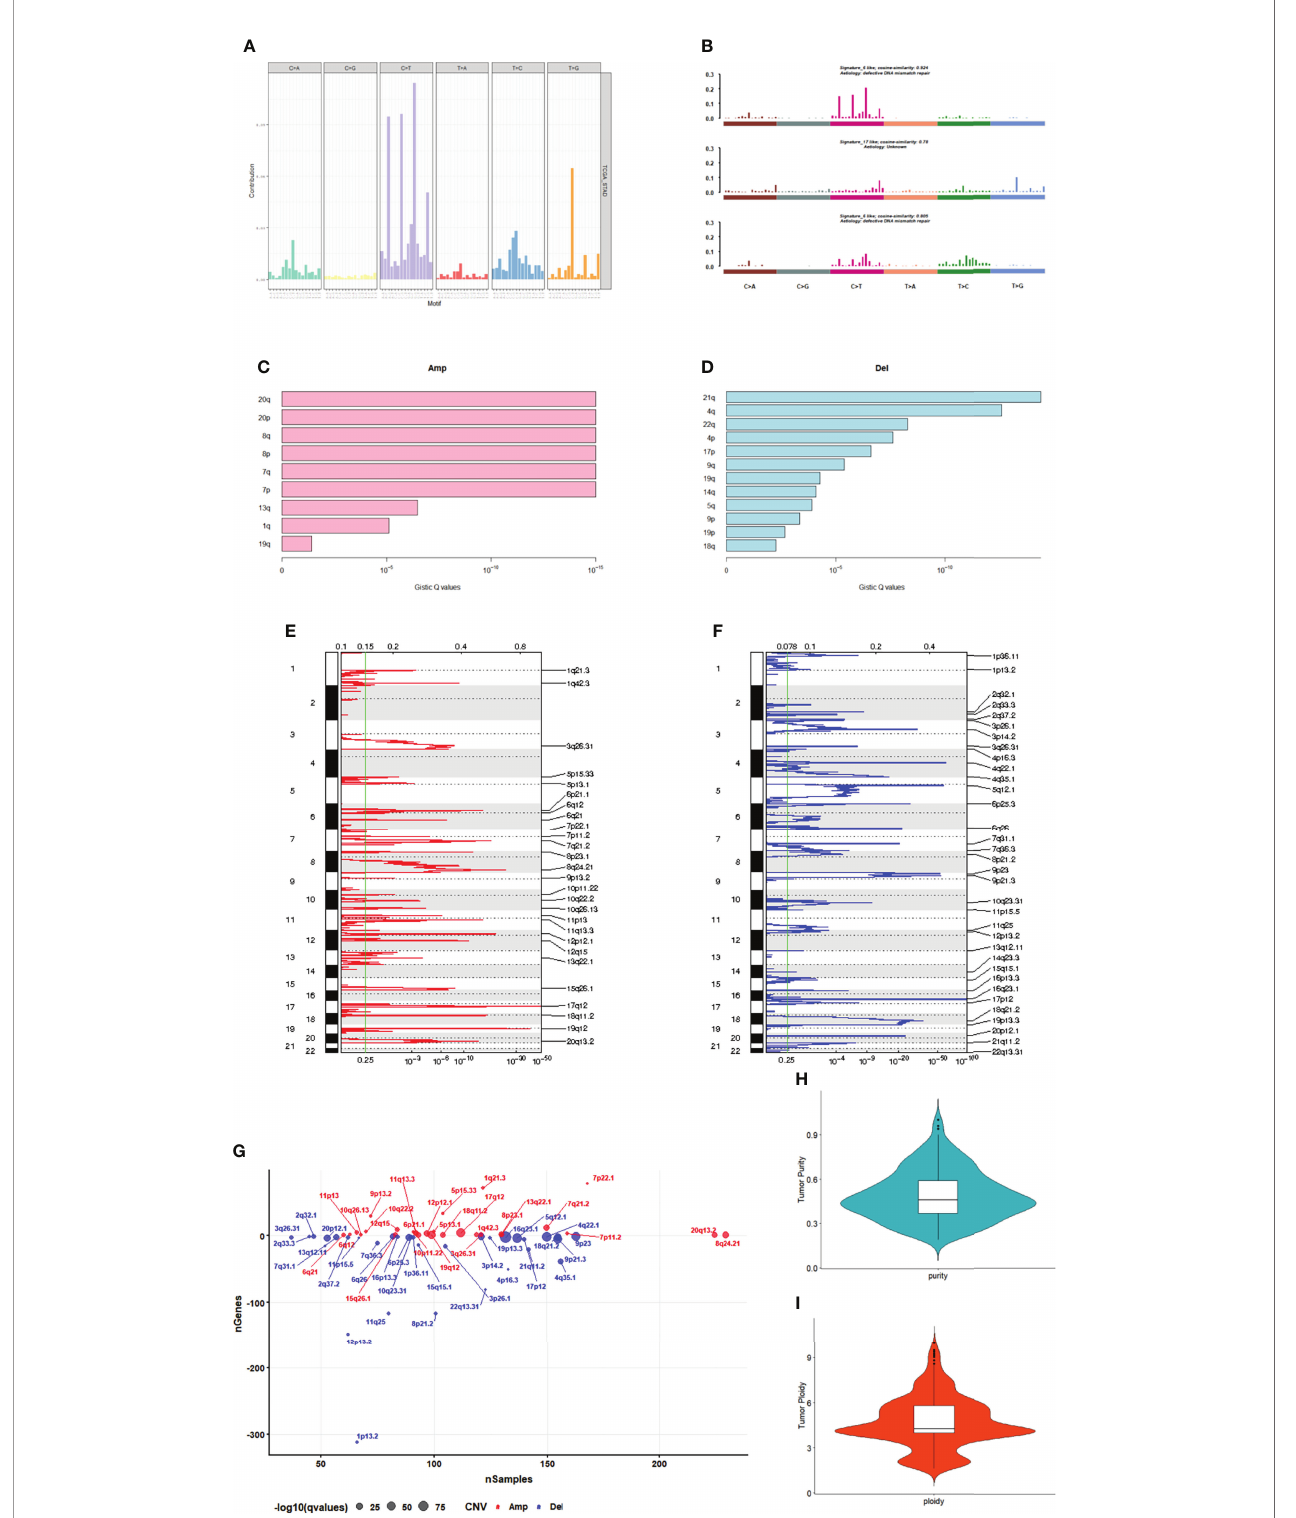
FIGURE 2 | Mutation and CNV analysis. (A) Mutation spectrum distribution. (B) The similarity between mutation features and cosmic mutation signature. (C) Ampli fi cation in chromosomal arms. (D) Deletion in chromosomal arms. (E) The distribution of CNVs ampli fi cated regions. (F) The distribution of CNVs deleted regions. (G) The number of genes in CNVs ampli fi cated or deleted regions. (H) The purity range of GC. (I) Tumor cell ploidy of